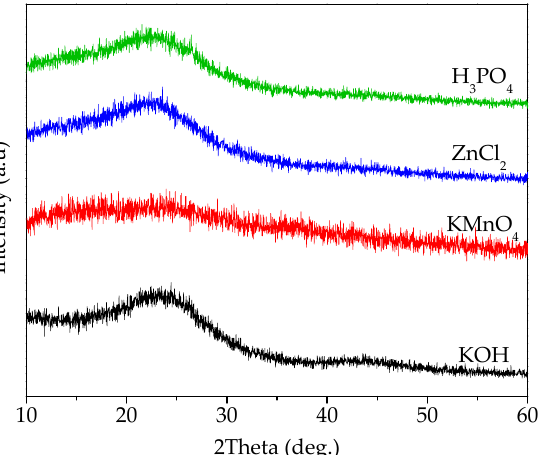
Figure 2. X-ray diffraction patterns of activated carbons from sago waste prepared using various chemical activating